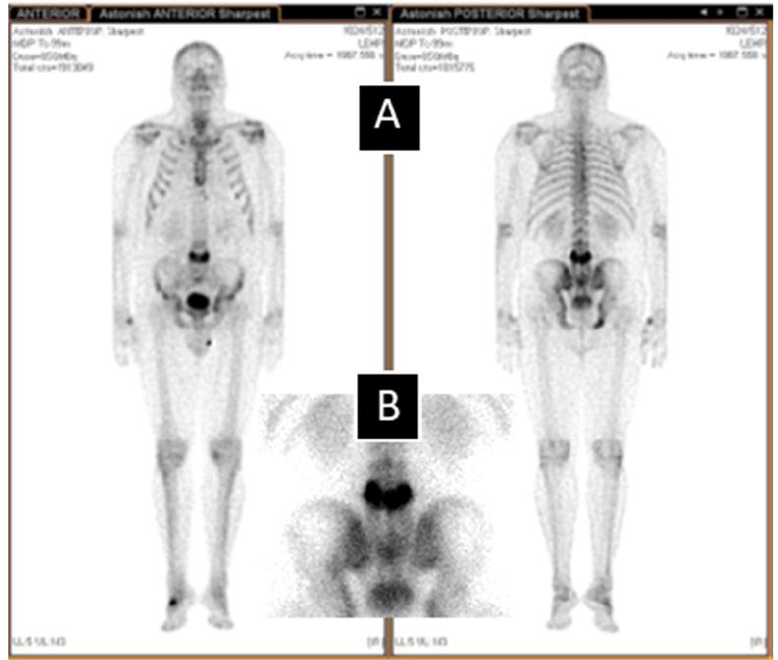
Figure 2. Bone scan images. ( A ) Whole body bone scan (anterior and posterior view) and ( B ) focused on the lumbar spine and pelvis.